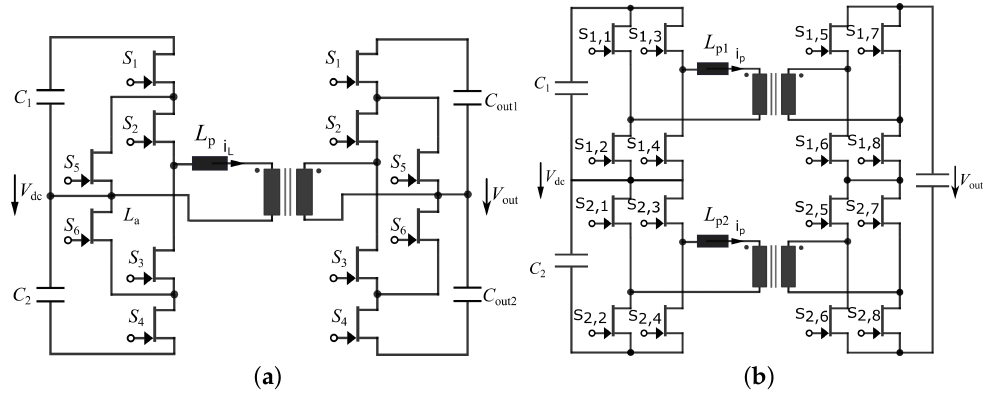
Figure 20. ( a ) Three-level ANPC dual active half-bridge converter proposed by [137]. ( b ) series-input series-output (SISO) DAB converter (derived from [99]) for 800 V EV